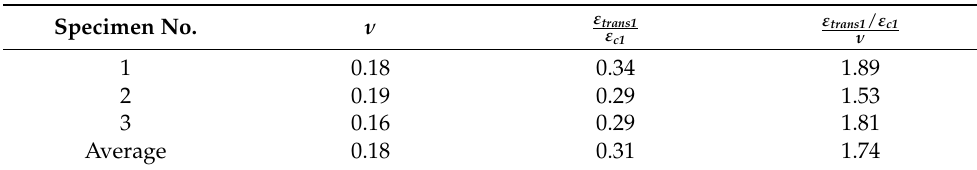
Table 8. Relationships between experimental Poisson’s ratio values, transverse, and longitudinal strains at ULS (following